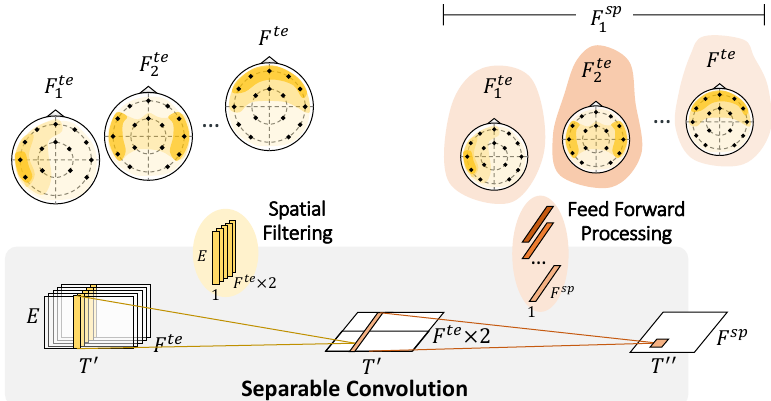
Figure 5. Spatial Convolution. Spatial processing separately convolves across the electrodes on the temporal feature maps. Feedforward processing subsequently weights the feature maps to extract temporal-–spatial features. Shading represents how the network emphasizes or understates the corresponding feature